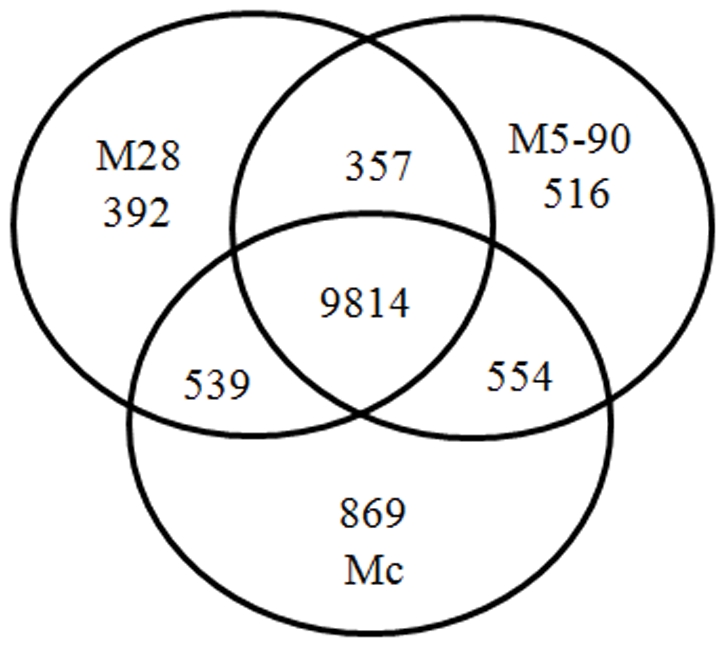
Comparative analysis of tag-mapped transcripts in the three libraries.A Venn diagram was created to quantify the overlap in the response. 10,171 transcripts were identified in both libraries, and 392 and 516 transcripts were present in the M28 and M5-90 libraries, respectively.